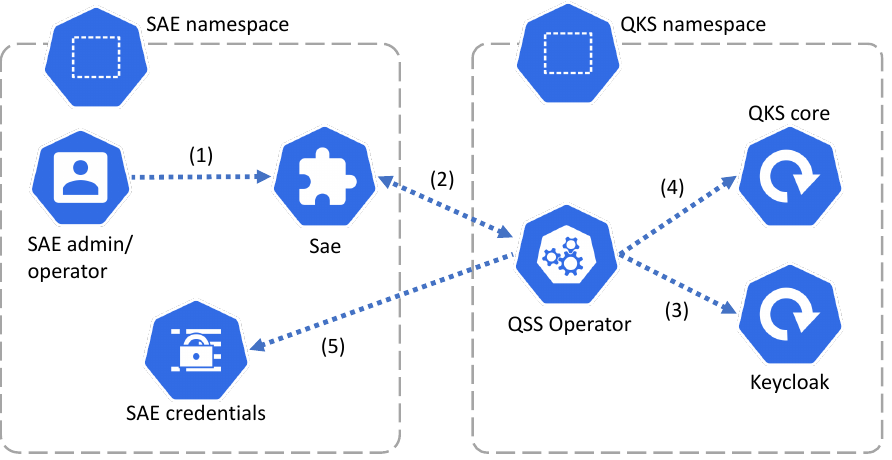
Figure 6. SAE registration process. SAE admin/operator creates a resource of type Sae (1). QSS operator monitors resource creation (2). When it finds the new Sae it starts the registration to Keycloak (3) and the QKS core (4). At the end of the process it retrieves the SAE credentials